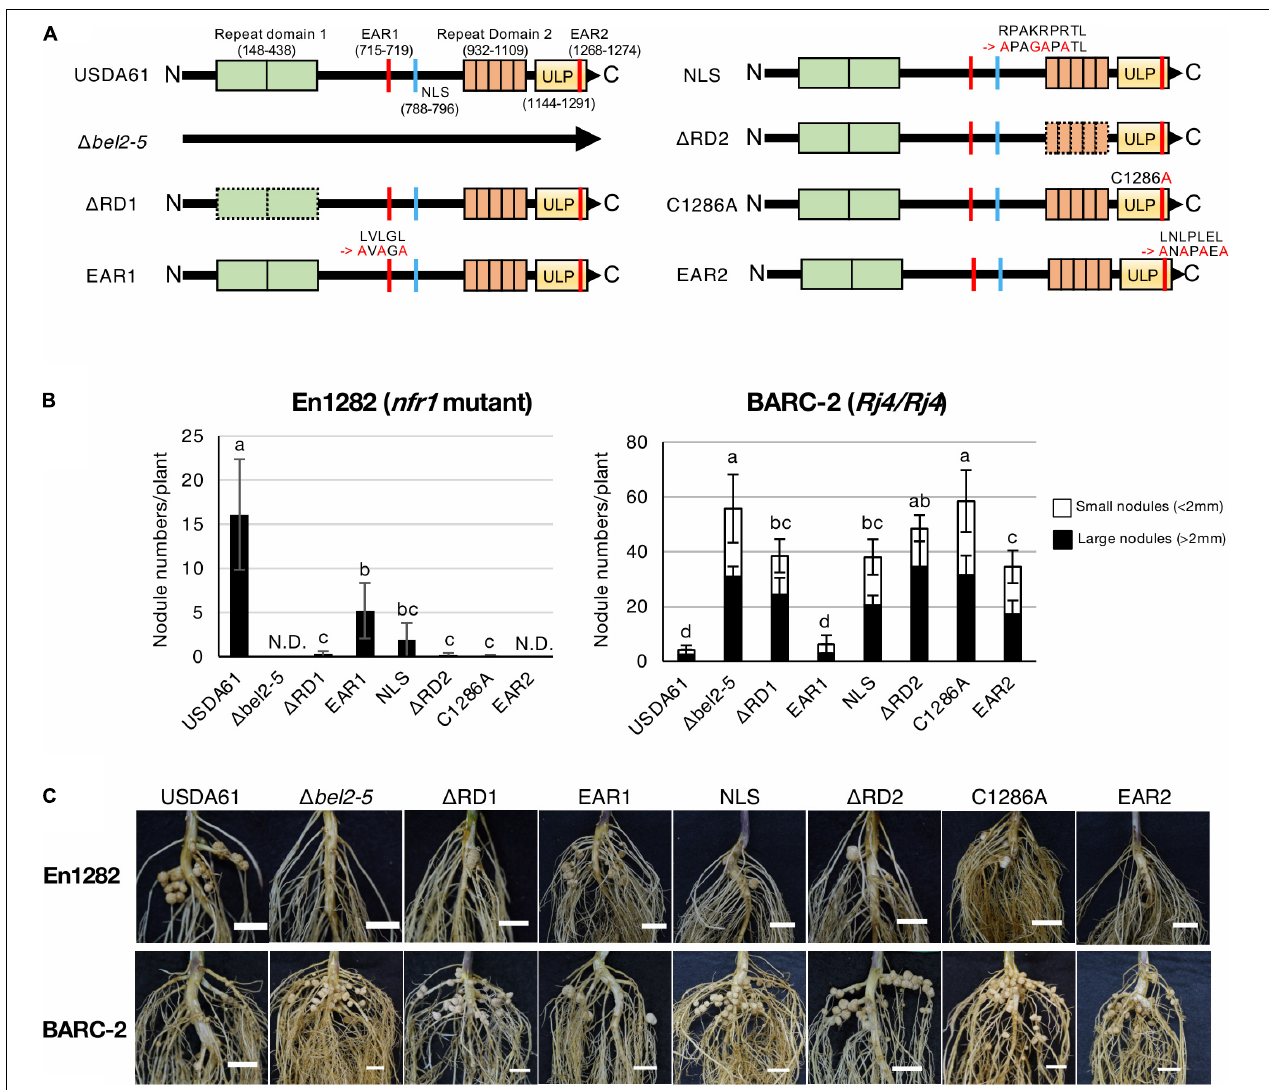
FIGURE 1 | Nodulation phenotypes of B. elkanii USDA61 wild-type and the bel2-5 deletion mutant and its derivatives (substitutions or deletions) on En1282 ( nfr1 mutant) and BARC-2 ( Rj4 / Rj4 ) soybean plants. (A) Schematic representation of Bel2-5 and its mutant derivatives in USDA61 and mutant strains. Bel2-5 possesses two internal repeat domains, two ethylene-responsive element-binding factor-associated amphiphilic repression (EAR) motifs, a nuclear localization signal (NLS), and a ubiquitin-like protease (ULP) domain. (B) Nodulation of G. max cv. En1282 and BARC-2 inoculated with wild-type and bel2-5 mutant strains of B. elkanii USDA61. Nodule numbers were counted at 30 days after inoculation (dai). The values represent the mean ± SD ( n = at least 10 plants, from two independent inoculation tests). N.D., not detected. Means followed by different letters are significantly different at the 0.05 level by Tukey’s test. (C) Roots of En1282 and BARC-2 inoculated with wild-type and mutant strains of B. elkanii USDA61. Roots were photographed at 30 dai. Scale bars, 1 cm. USDA61, Bradyrhizobium elkanii wild-type; (cid:49) bel2-5 , bel2-5 knockout mutant; (cid:49) RD1, repeat domain I deletion mutant; BERD1; EAR1, amino acid substitution mutant of the EAR1; BEEAR1; NLS, amino acid substitution mutant of the NLS; BENLS; (cid:49) RD2, repeat domain 2 deletion mutant; BERD2; C1286A, amino acid substitution mutant of the ULP domain; BEC1286A; and EAR2, amino acid substitution mutant of the EAR2;